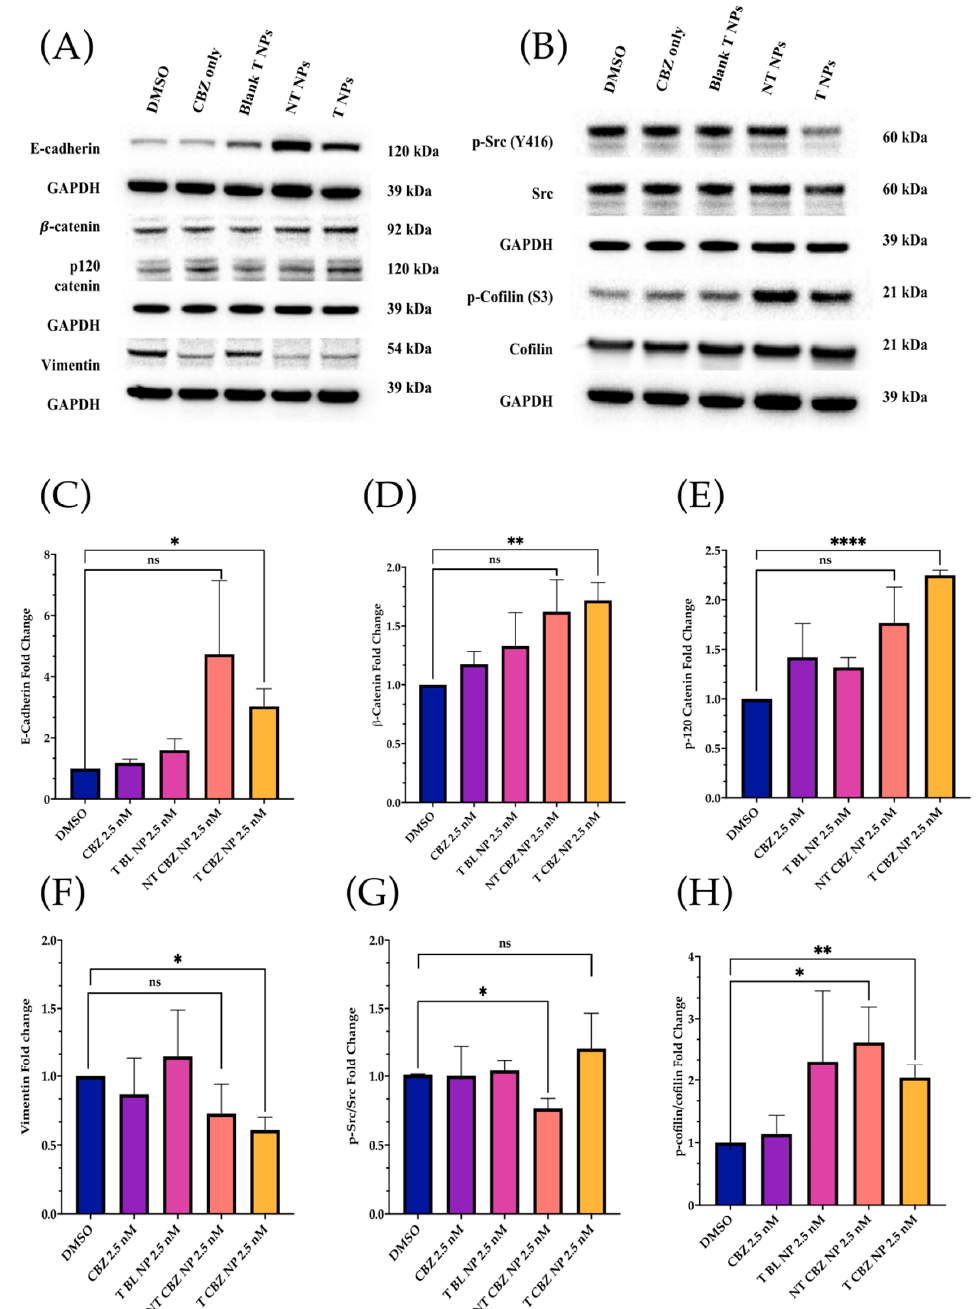
Figure 7. Western Blot Analysis of key signaling proteins. All Western Blot experiments were conducted at sub-IC 50 concentrations. ( A ) E-cadherin was lower after treatment with CBZ alone but increased with NP treatments. In addition, β -catenin and p-120 catenin expressions were higher with CBZ-loaded NPs, but Vimentin was lower in CBZ and drug-loaded treatments than in control and T BL NPs. ( B ) Activated Src (p-Src) and cofilin (p-cofilin) were lower in drug-alone and drug-loaded NPs with respect to controls. Conversely, total Src and total cofilin were not lower with respect to the controls. ( C – H ) Quantification of the Western Blot analysis. All the proteins showed a significant change after T CBZ NPs treatment at 2.5 nM, except that the p-Src/Src ratio only shows significance with NT CBZ NPs. Note that the p-cofilin/cofilin ratio showed significance in both the NT and T CBZ NPs. ns = not significant, * p < 0.05, ** p < 0.01, **** p <